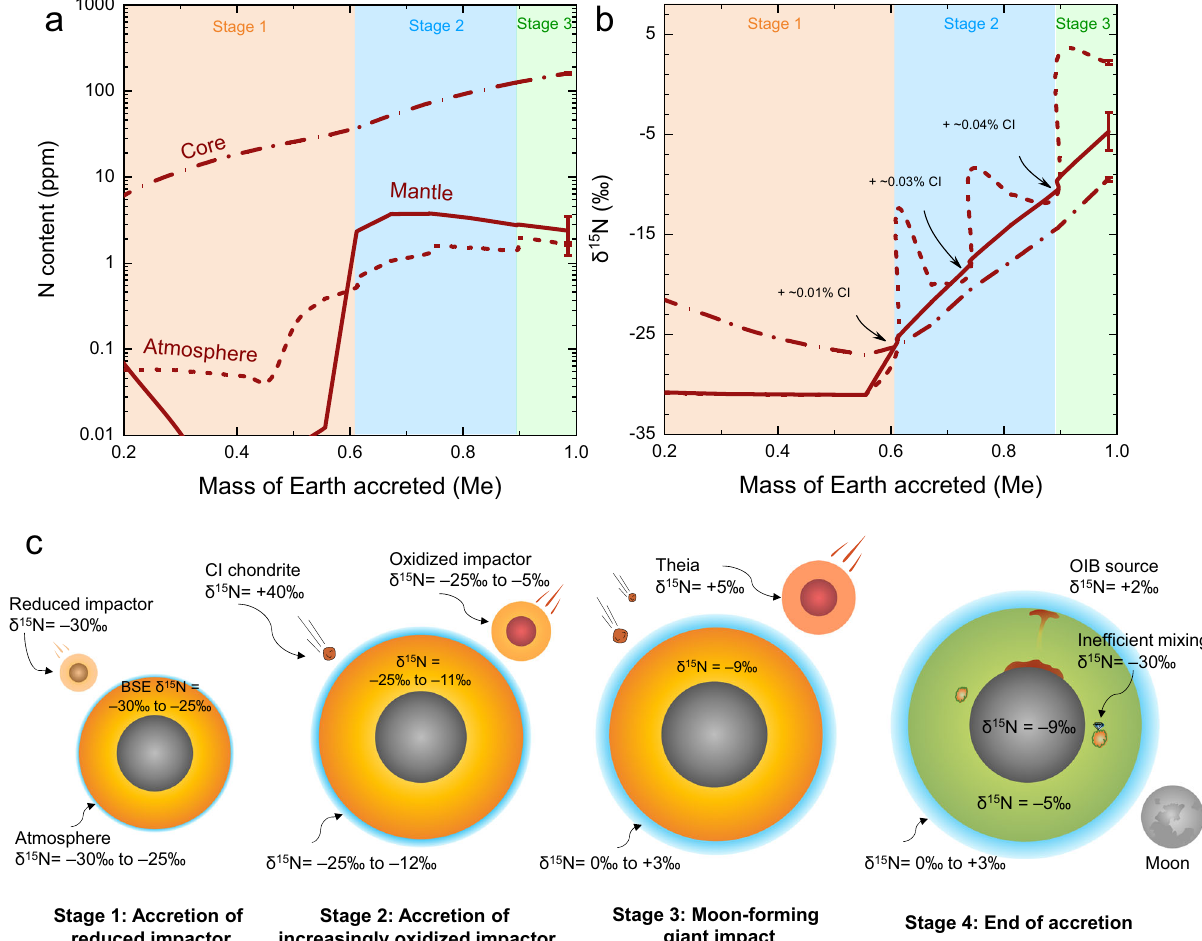
Fig. 4 | Earth ’ s heterogeneous accretion of nitrogen during its main accretion phase. a , b The N-content and -isotopic composition of the proto-Earth ’ s core, mantle, and atmosphere as a function of mass fraction accreted. At the end of Earth ’ s accretion, the N-content and δ 15 N of the proto-Earth ’ s mantle are ~2.4 ppm and − 4.7 ‰ , respectively, consistent with previous estimates for the present-day mantle 5,6,8 . The N-content of the proto-Earth ’ s atmosphere is ~1.7 ppm, consistent with previous estimates for Earth ’ s early atmosphere 52 (note that the ppm N in the atmosphere is based on the atmosphere N-mass normalized to the silicate Earth mass).The deliveryof oxidized,CI chondrite-like materialsplays an important role in enhancing the proto-atmosphere δ 15 N from − 30 ‰ to 0 ‰– +3 ‰ , which are close to Earth ’ s surface δ 15 N (atmosphere+ crust; Fig. 1). Earth ’ s core contains morethan